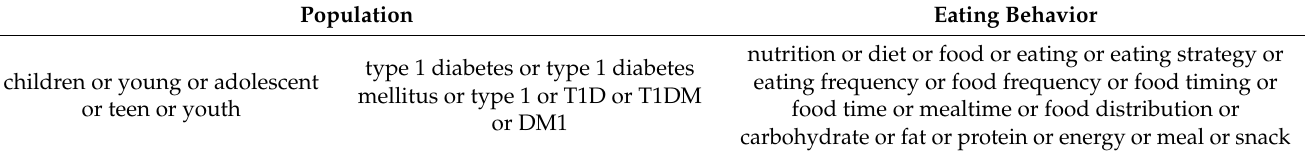
Table 1. Search Strategy Keywords.